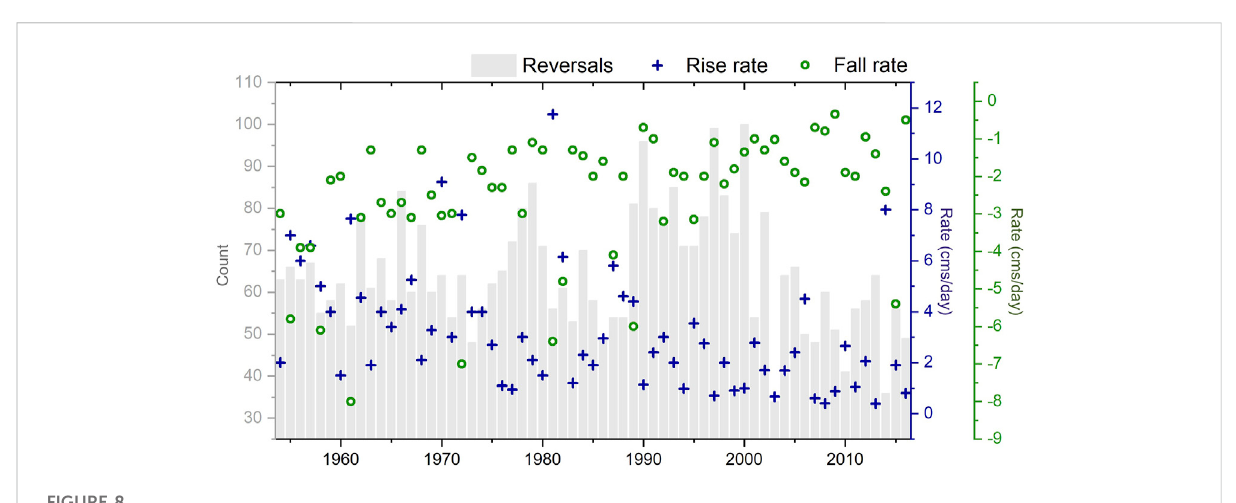
FIGURE 8 Variation of change rate and frequency of river